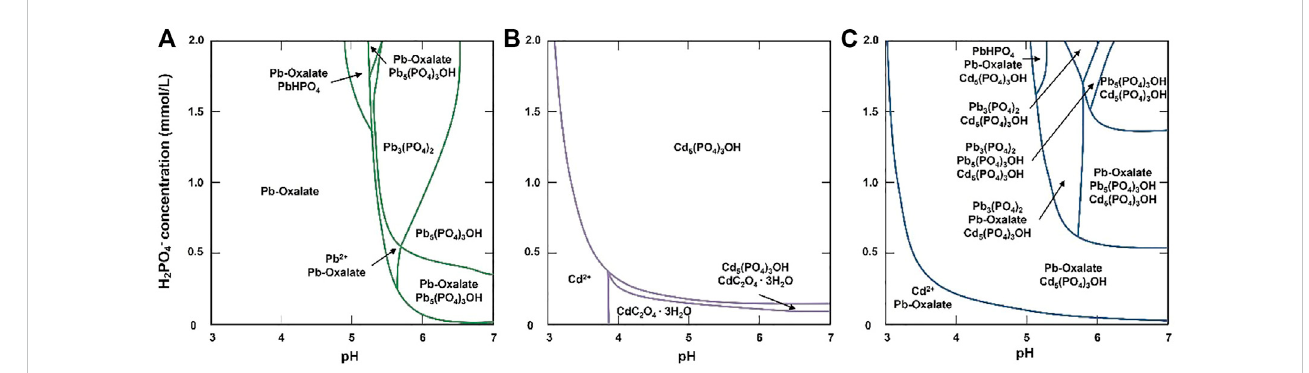
FIGURE 8 Diagrams of Pb and Cd phase with the changes of pH and H 2 PO 4 − concentrations in theTPb treatment (A) , TCd treatment (B) , and TPbCd treatment (C) .